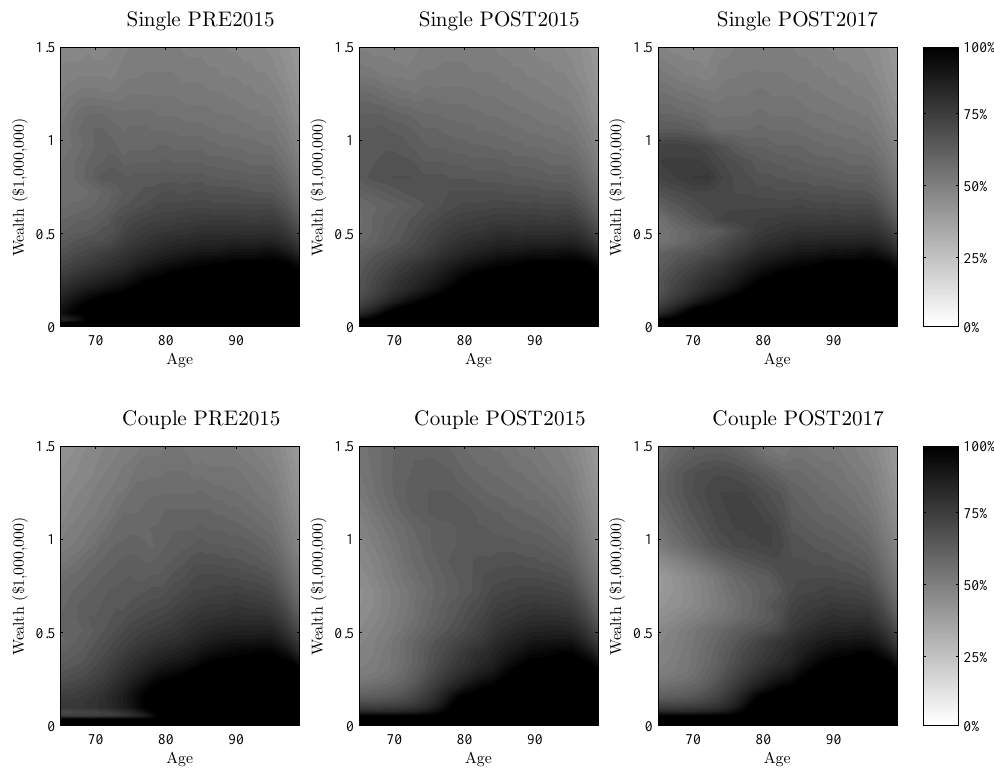
Figure 5. Optimal risky allocation for non-homeowner single and couple household, under each policy, given the low expected return ( µ =